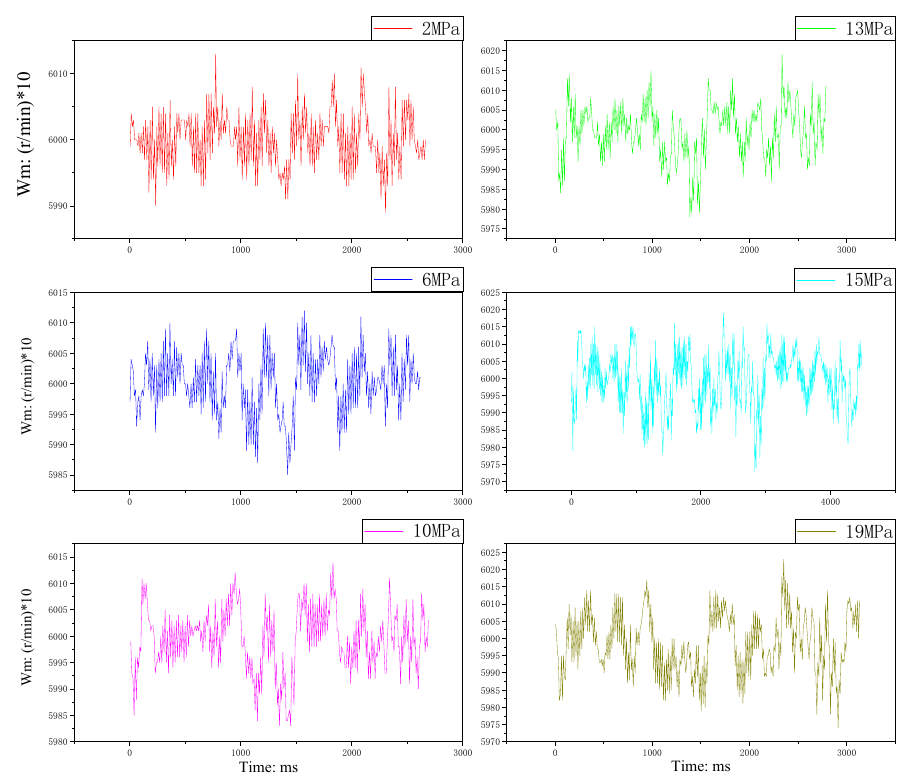
Figure 11. Constant speed (600 r/min)–variable pressure fluctuation graph related to SM speed.